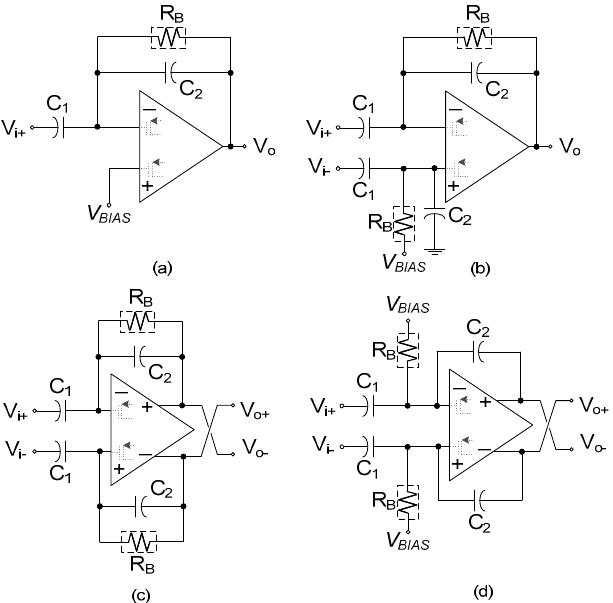
Figure 5. AC-coupled amplifiers. ( a ) Single-ended input and output. ( b ) Differential input and single-ended output. ( c ) Fully differential. ( d ) Alternative fully differential.